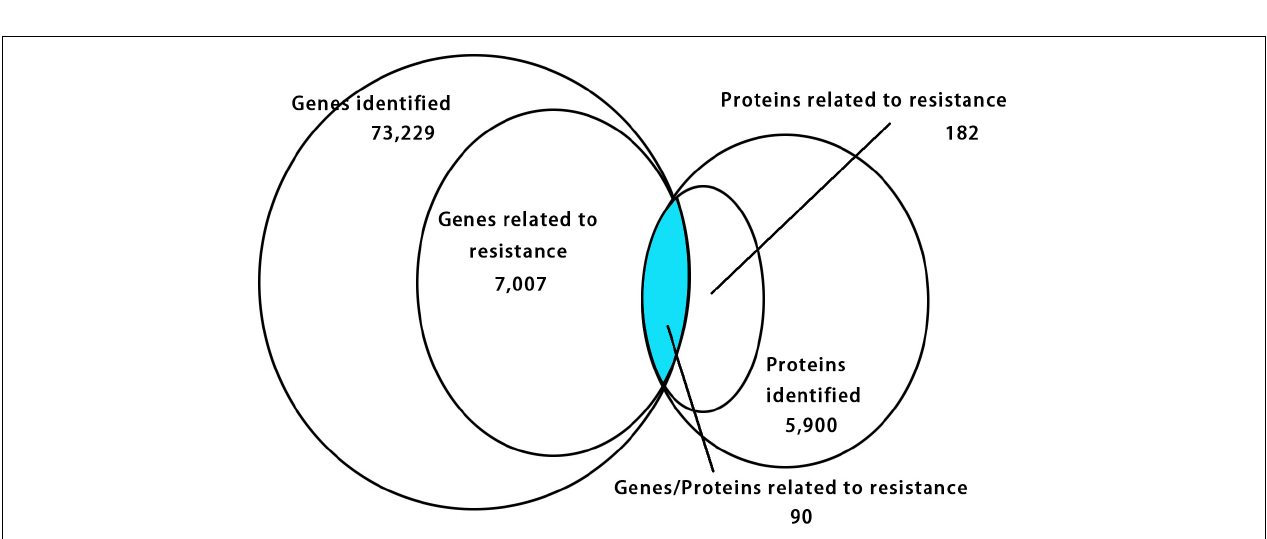
FIGURE 4 | Venn diagram showing relationship between the differentially expressed proteins and genes. The values in each circle represents the quantity of genes or proteins, including identified genes and proteins and genes and proteins related to resistance, respectively, genes/proteins related to resistance together. The cut-off value of log 2 fold changes for up-regulated and down-regulated gene/protein was +1/–1.